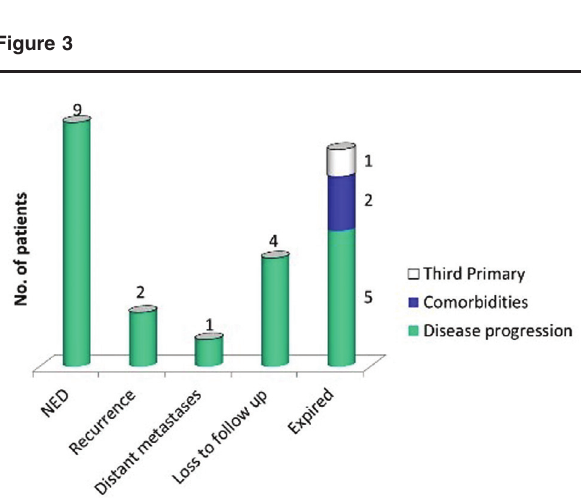
Outcome of patients after reirradiation.